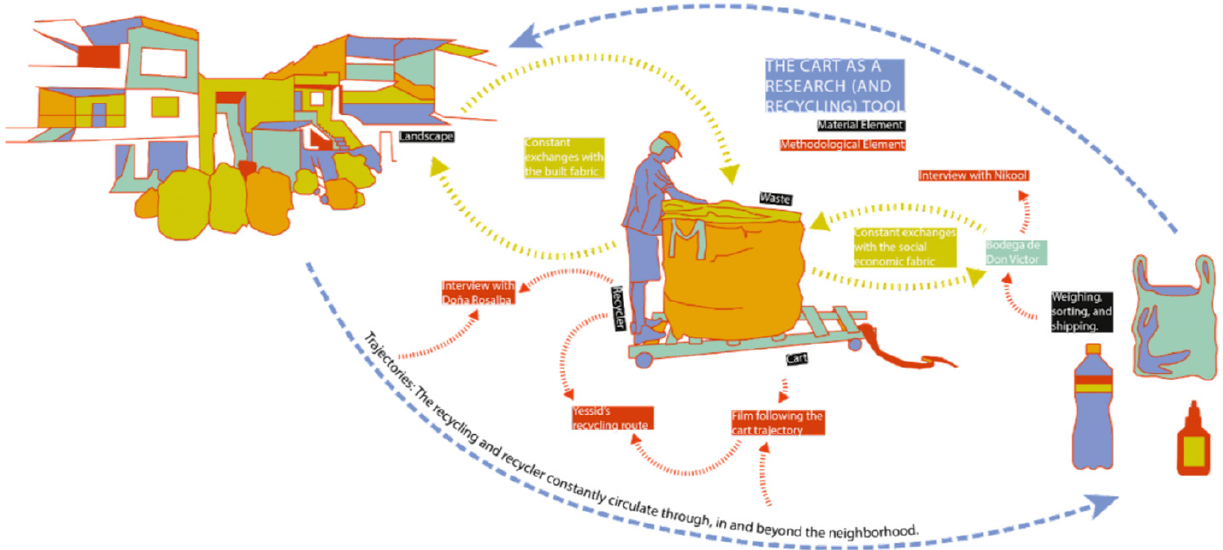
Figure 5. Circuits of recycling in Moravia. Source: Drawn by Livelihoods Team cohort 2020–2021 for Atlas of Living Heritage. Yessid, a young man who began recycling out of